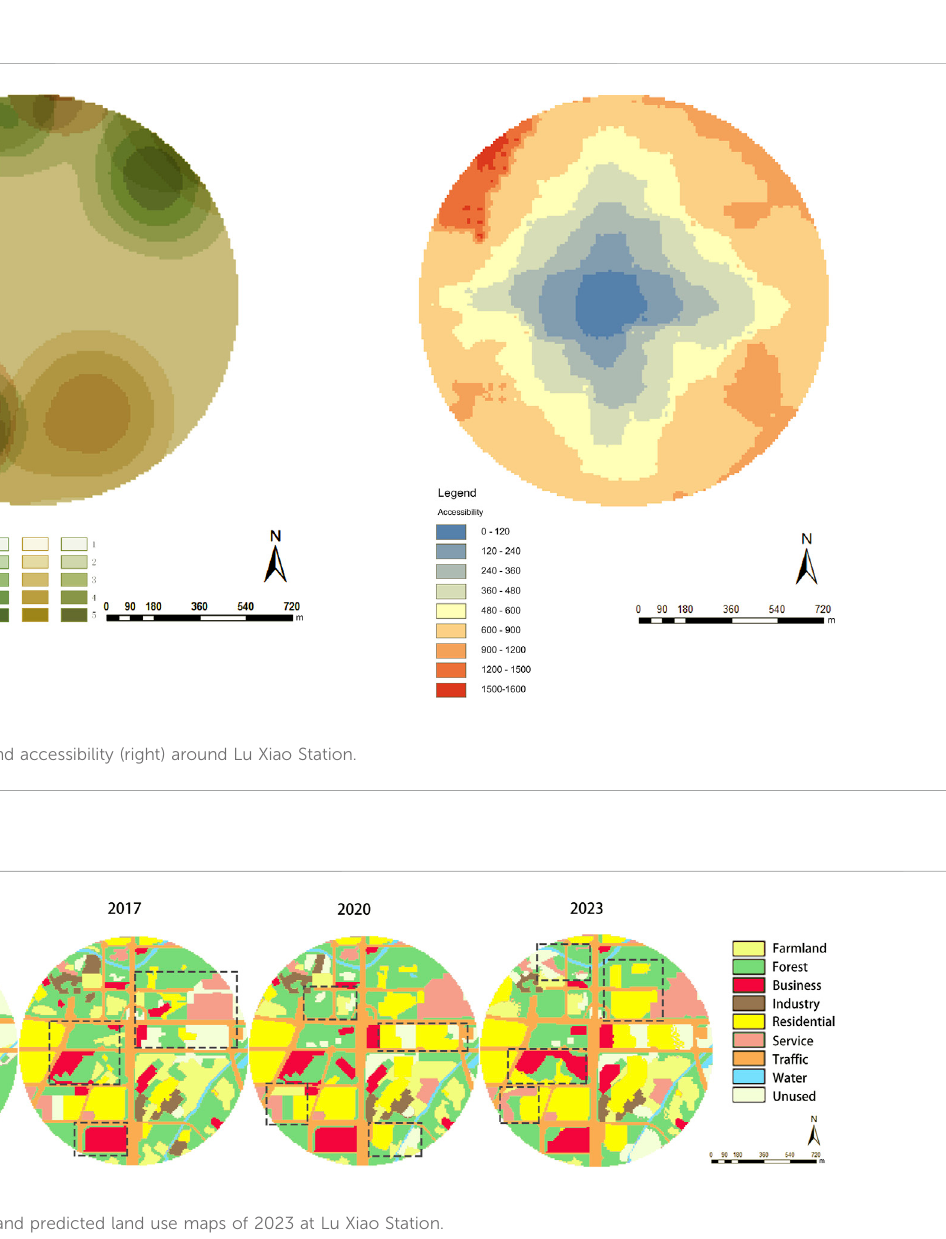
Frontiers in Environmental